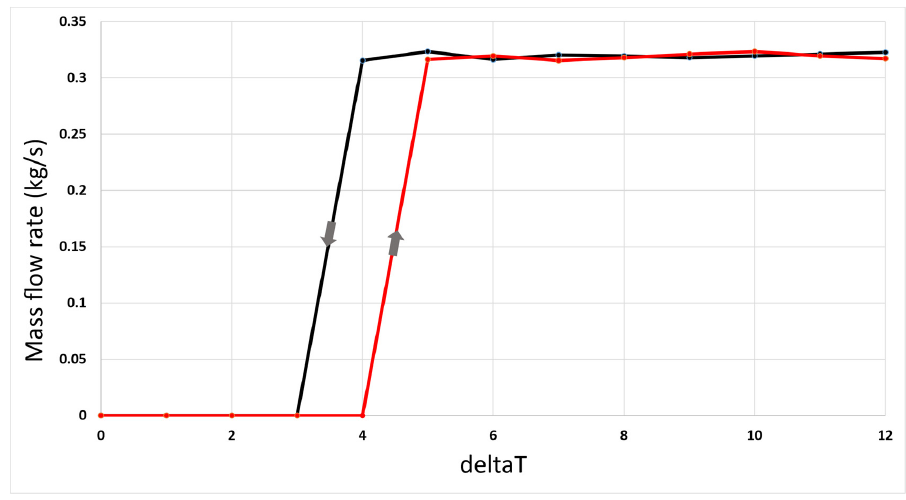
Figure 10. Measured ESCO PT-20+